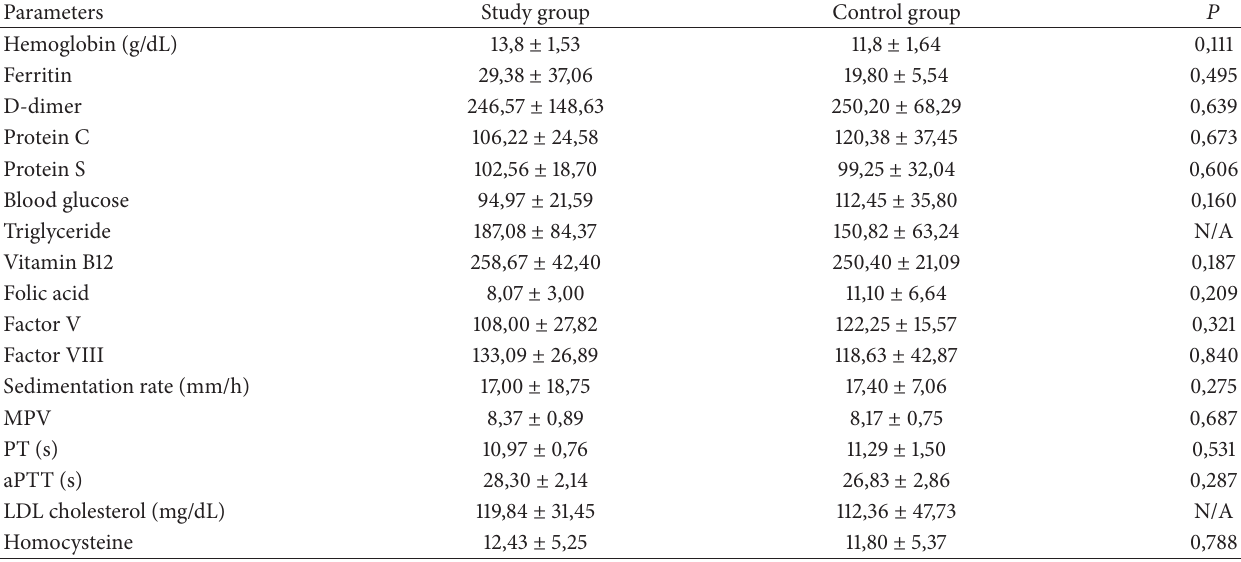
Table 3: The comparison of haematological and biochemical parameters in the study and the control group.